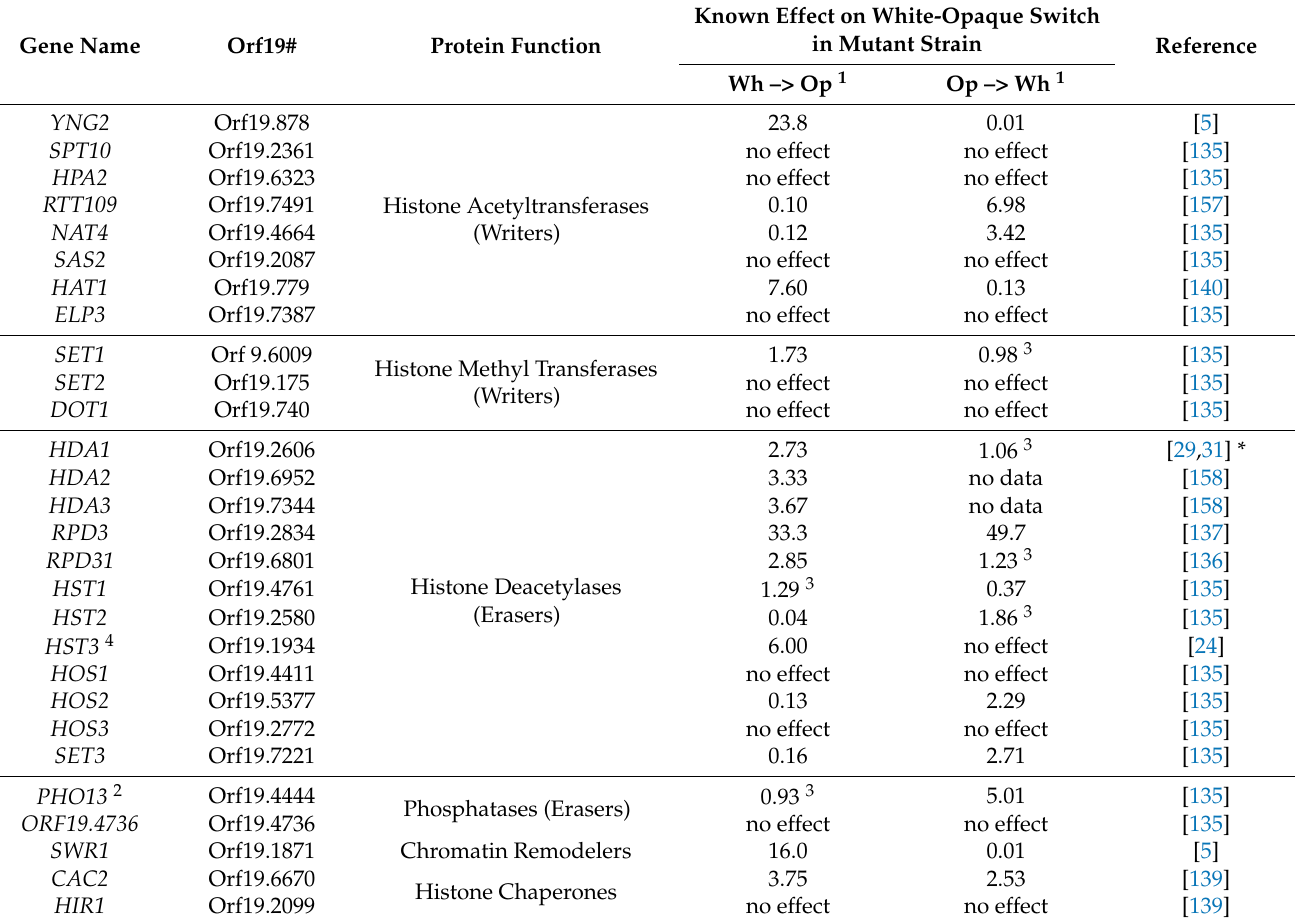
Table 2. Genes encoding known or predicted writers, erasers, chromatin remodelers and histone chaperones analyzed for their impacts on white-opaque